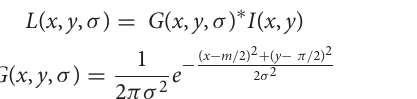
improved Harris algorithm overcomes the shortcomings of